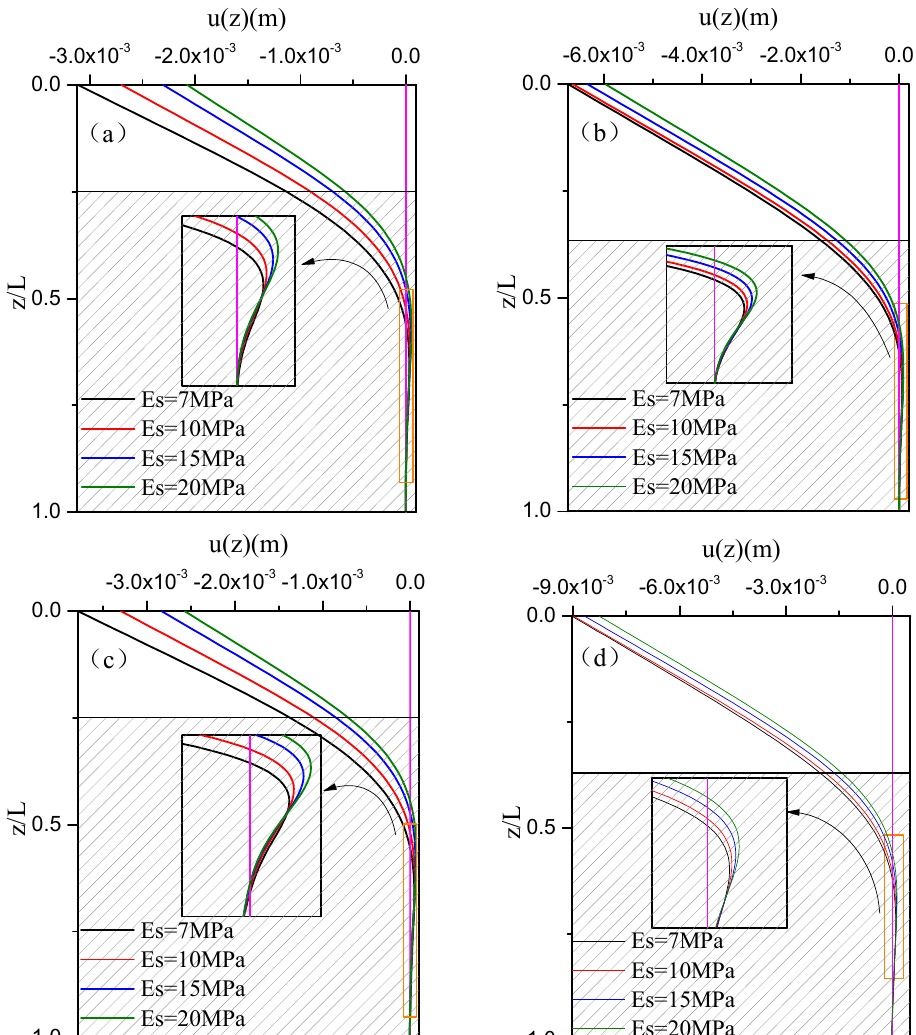
Figure 8. Effect of the elastic modulus of soil on the dynamic response of the single pile under varied scour levels: ( a ) Free-fixed pile, scour level-0; ( b ) Free-fixed pile, scour level-5 ( c ) Free-free pile, scour level-0; ( d ) Free-free pile, scour level-5.